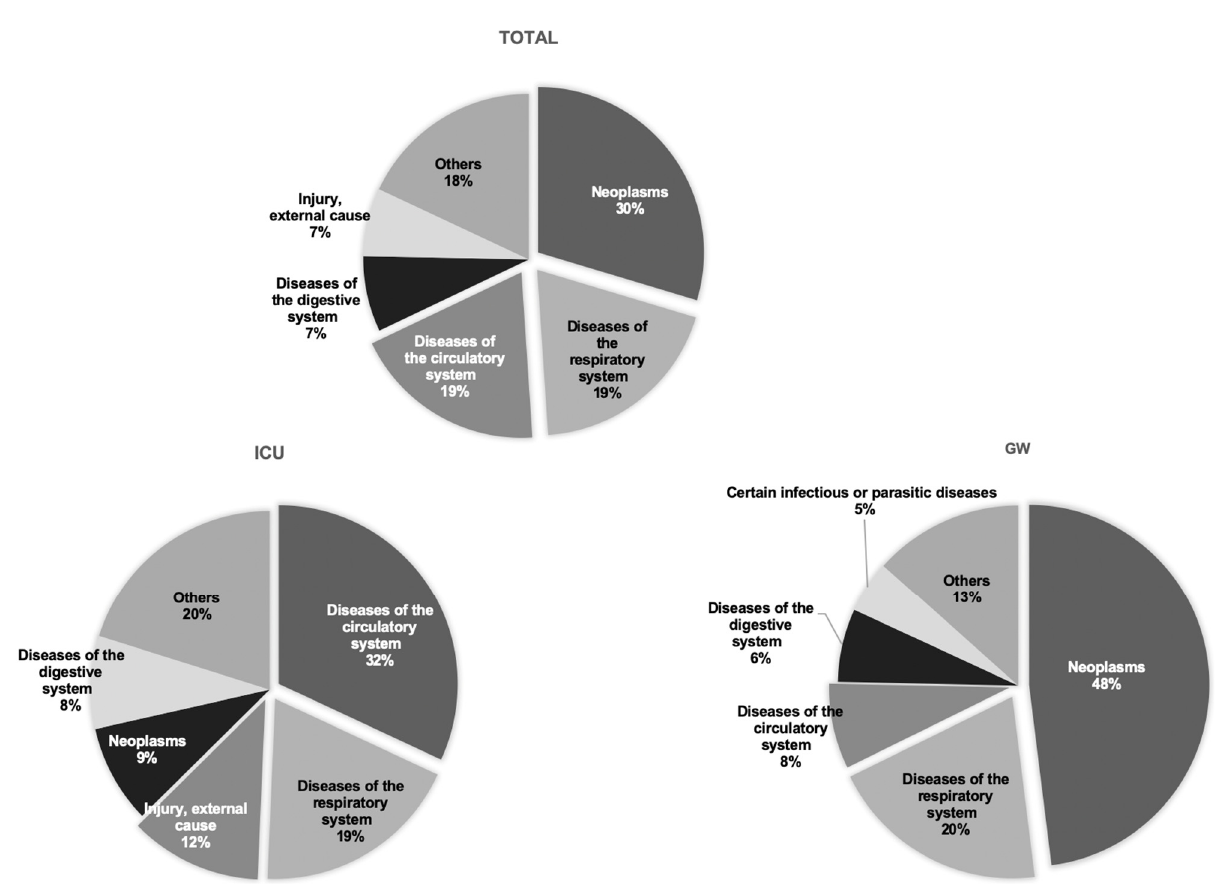
Figure 3. Top 5 disease classifications that lead to death among patients admitted through the emergency department. GW, general ward; ICU, intensive care unit.